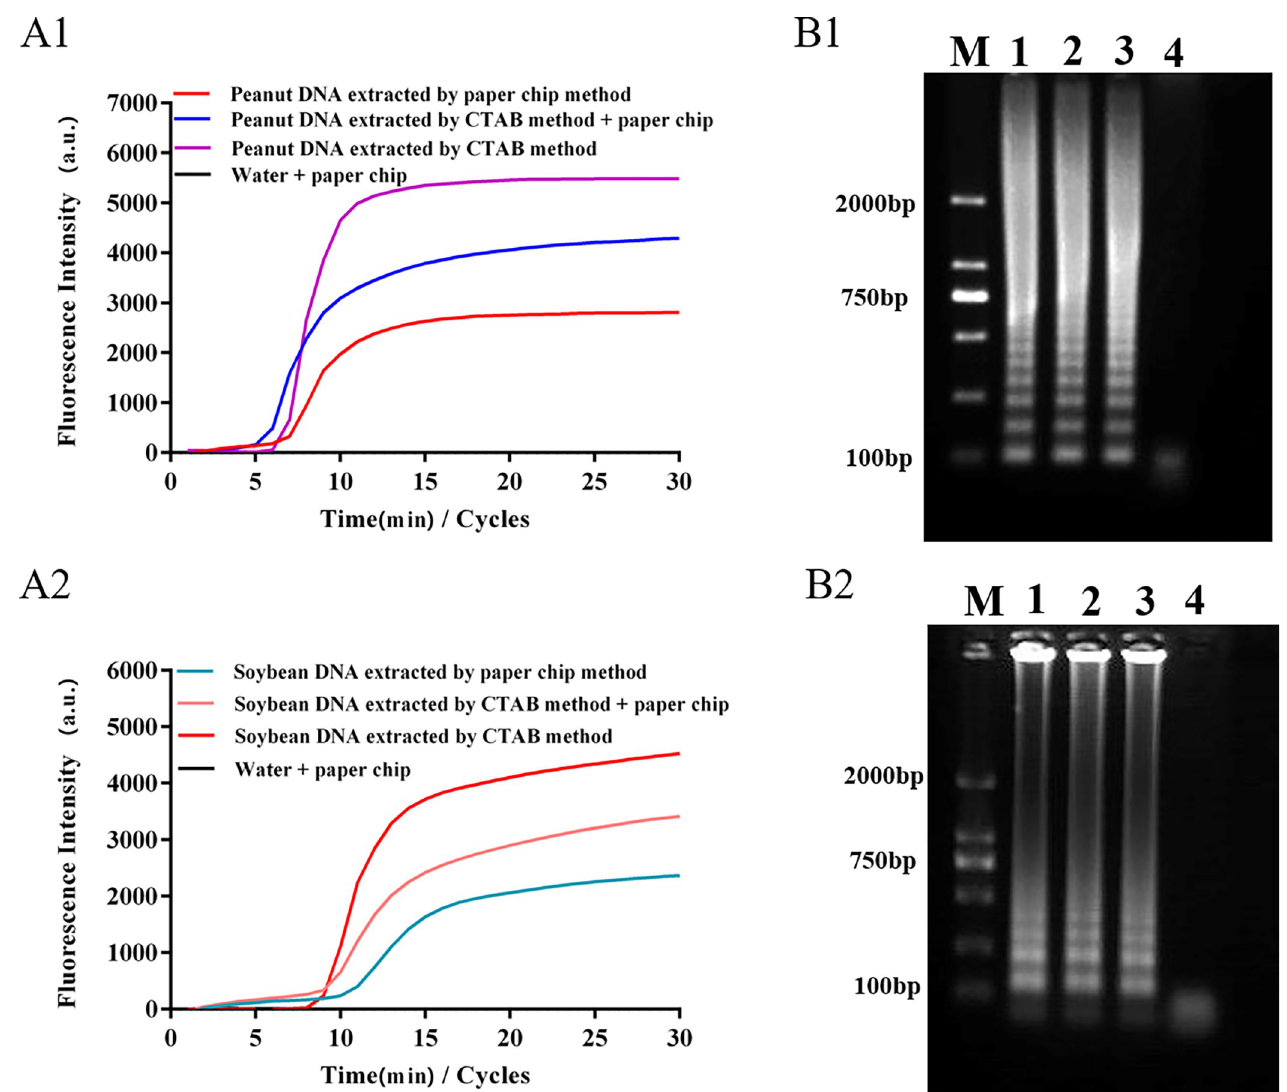
Fig 4. LAMP detection and electrophoresis verification based on the extraction DNA by paper-based microfluidics. Notes: A1 & A2, LAMP amplification curves of peanut and soybean; B1 & B2, corresponding ladder electrophoresis bands of peanut and soybean.